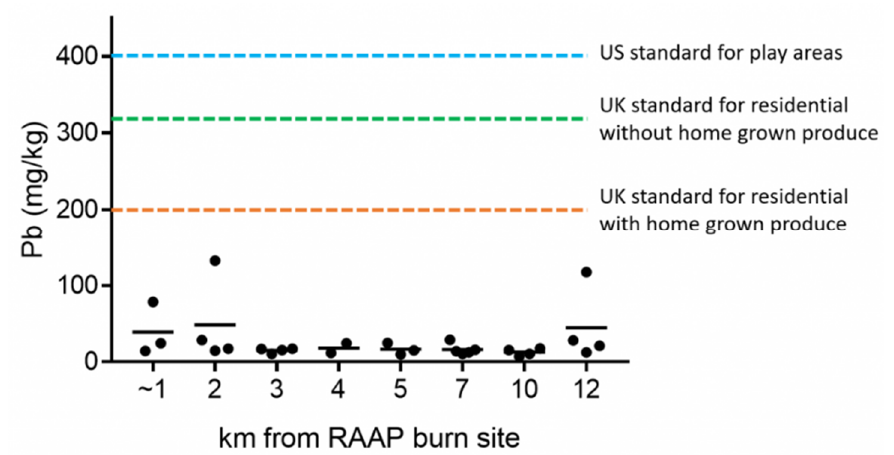
Figure 6. Graph comparing the amount of lead found in each soil collection site—each of which are separated by its distance from the open burning grounds. The most noticeable points are a site 1 km away that had approximately 80 mg/kg lead, a site from 12 km away with approximately 125 mg/kg lead, and the highest amount of lead, approximately 140 mg/kg, found 2 km away. RAAP—Radford Army Ammunition Plant.